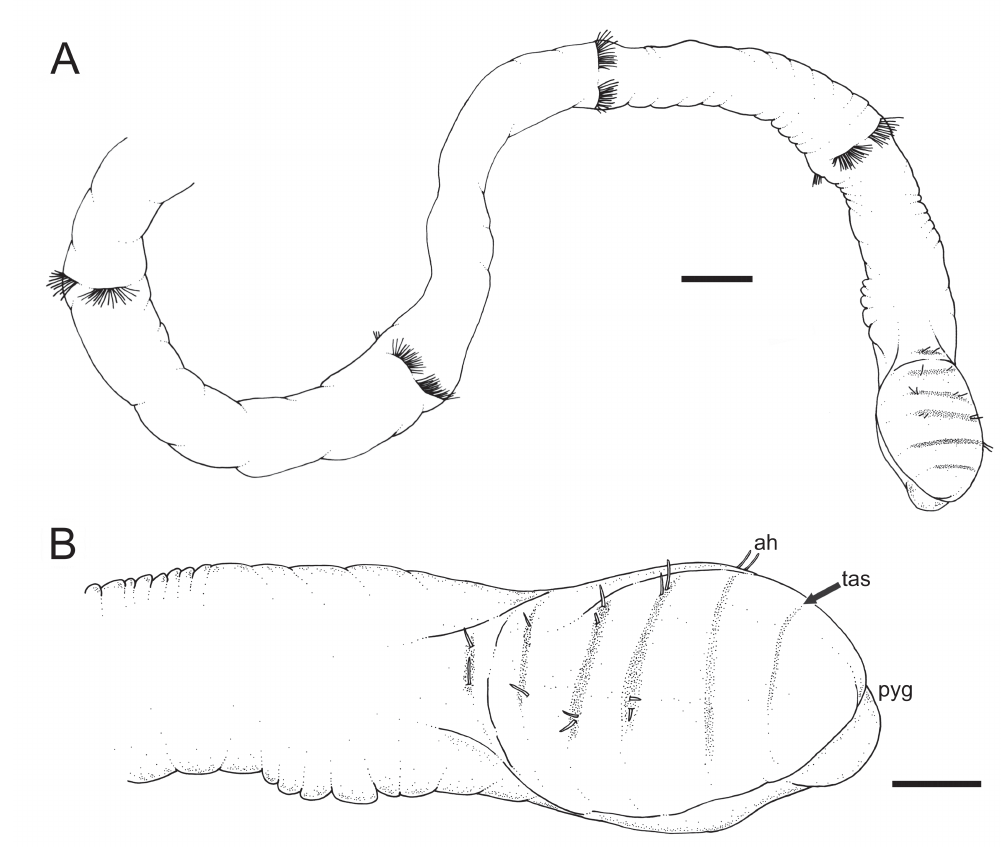
Fig. 3. Heterospio indica sp. nov., paratype (MNCN 16.01/16998). A . Posterior end (scale bar = 200 m m). B . Detail of bulbous region of posterior end (scale bar = 100 m m). Abbreviations: ah = acicular hook; pyg = pygidium; tas = terminal achaetigerous